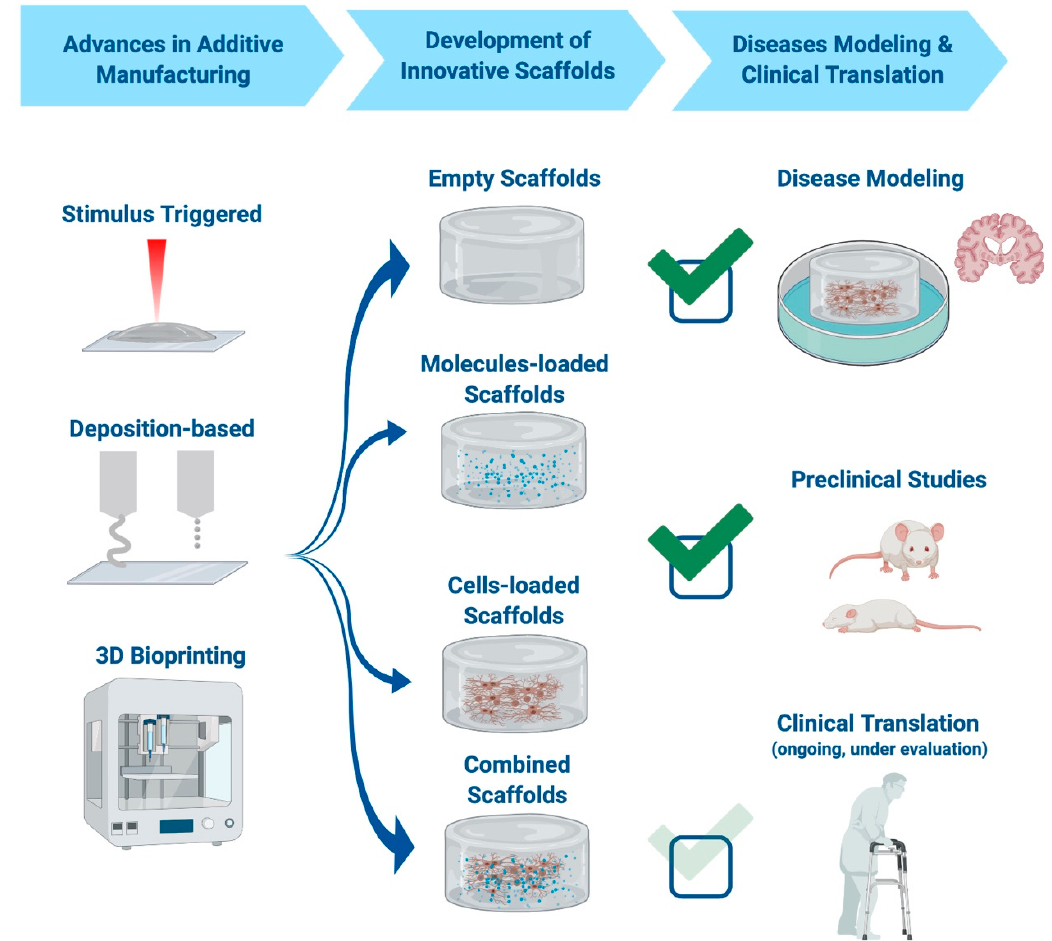
Figure 3. Use of additive manufacturing techniques in neurodegenerative diseases. Scaffolds can be either printed or bio printed, and embedded with molecules, cells, or even a combination of the two to increase their therapeutic efficiency. Recent advances in production technologies have shown a relevance for these techniques in disease modeling and preclinical models of neurodegenerative diseases. Current efforts are focusing on the development of safe and efficient strategies for human clinical translation. Made in ©BioRender—biorender.com.